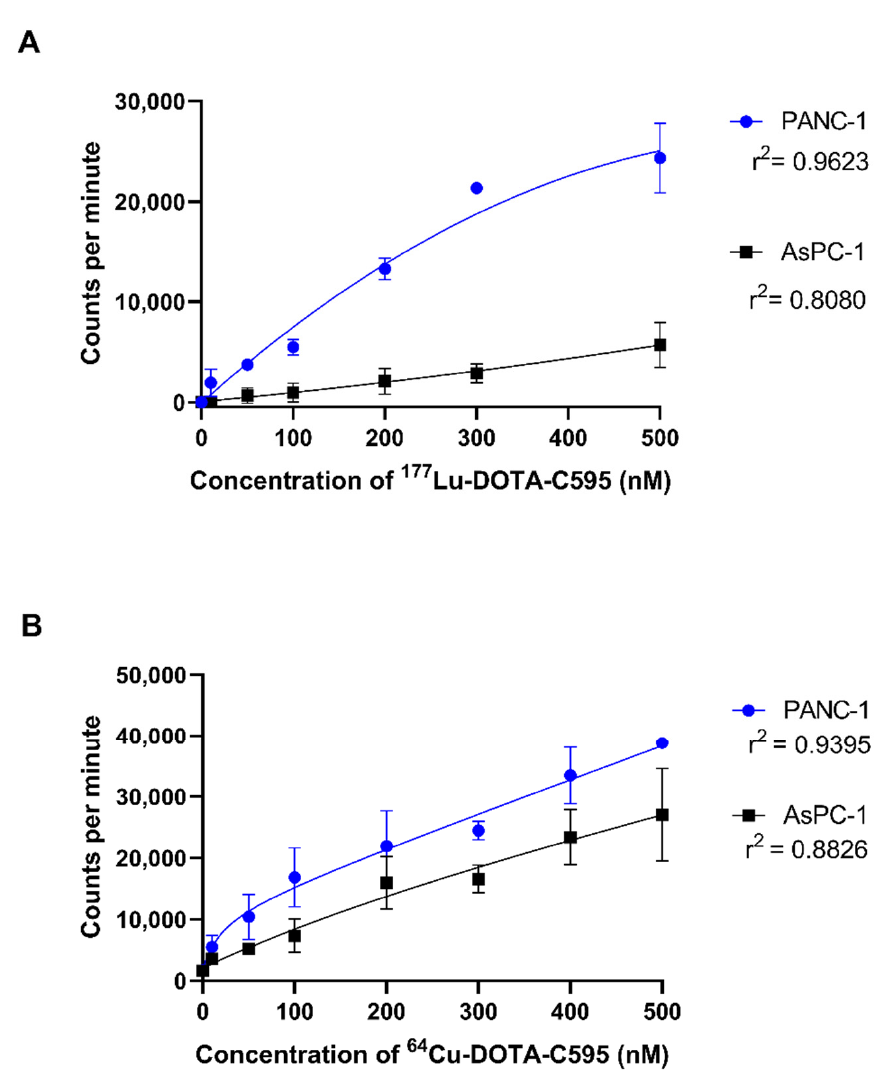
Figure 7. Cell binding (1 × 10 5 cells) of ( A ) 177 Lu-DOTA-C595 and ( B ) 64 Cu-DOTA-C595 to PANC-1 and AsPC-1 cell lines. Data presented as mean ± standard deviation.